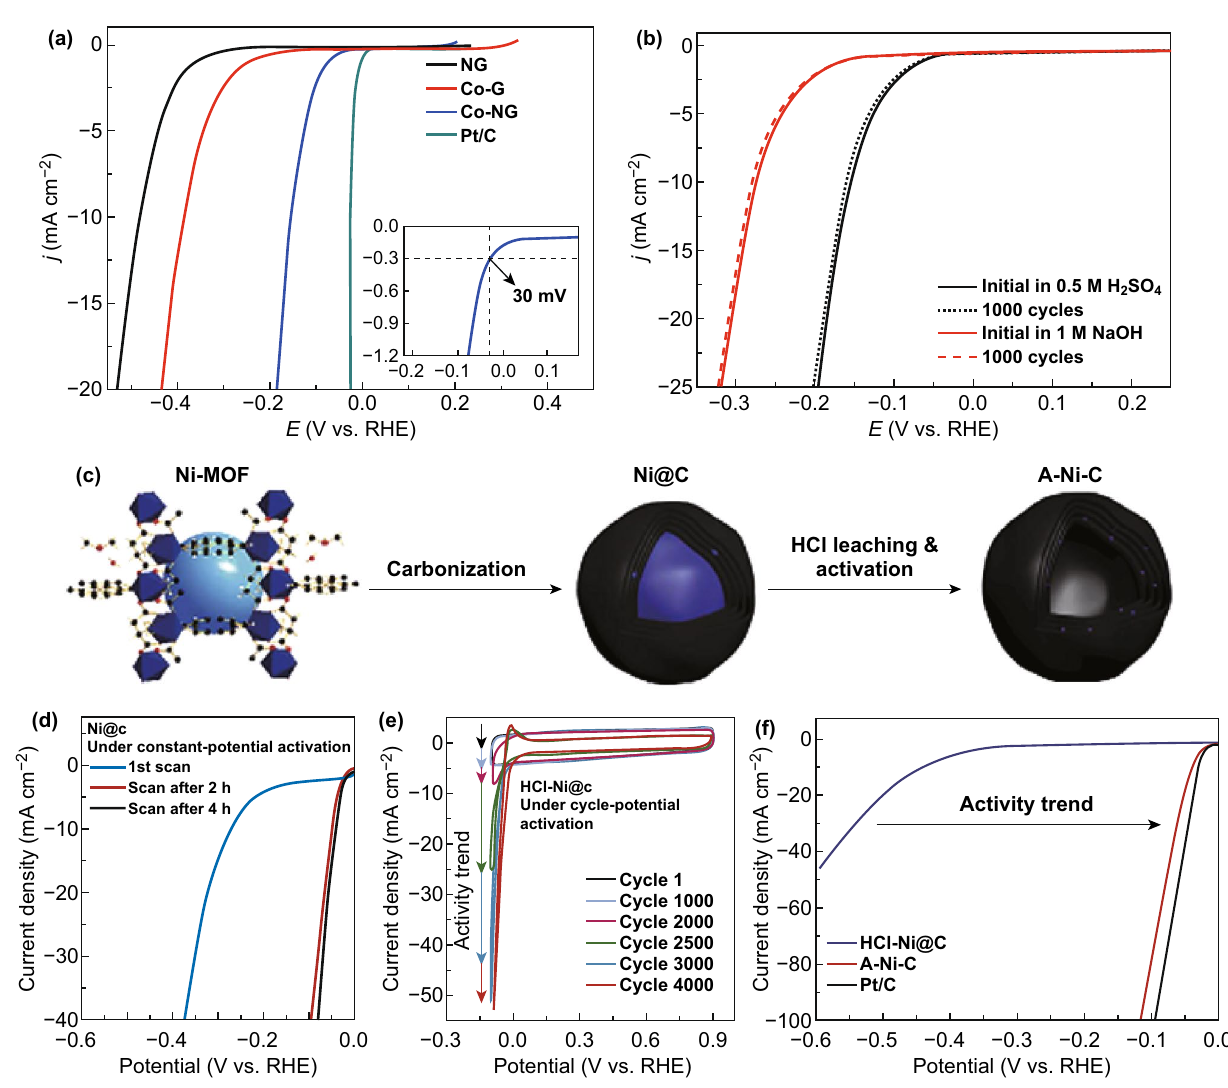
Fig. 14 a The polarization curves of Co–G, NG, Co–NG and commercial Pt/C in acidic solutions. b Polarization curves for the Co–NG before and after 1000 CV cycles in acidic and alkaline solutions, respectively. c The preparation and activation process of the Ni-C materials. d Polari- zation curves before and after activation at a constant potential. e CVs of HCl-Ni@C. f Polarization curves for A–Ni–C, HCl-Ni@C, and Pt/C catalysts. Panels are reproduced from Refs. [94, 179] with permission. Copyright 2015 and 2016 Nature Publishing